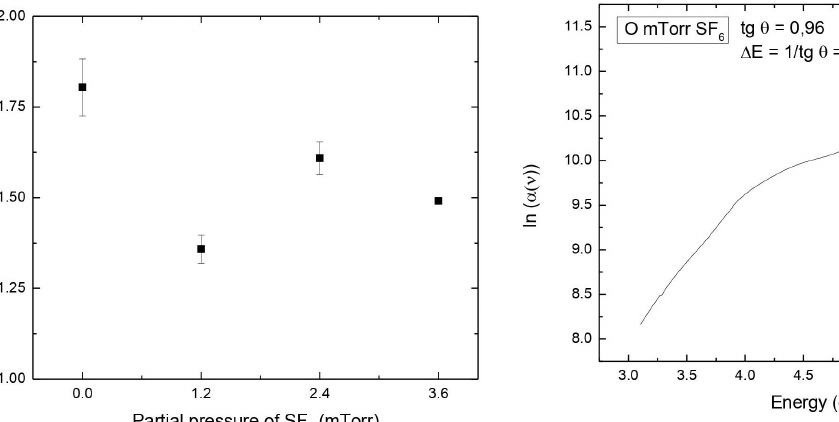
Figure 11. Example (of the unfluorinated film) of the graph allowing . the calculation of the Urbach energy. SF